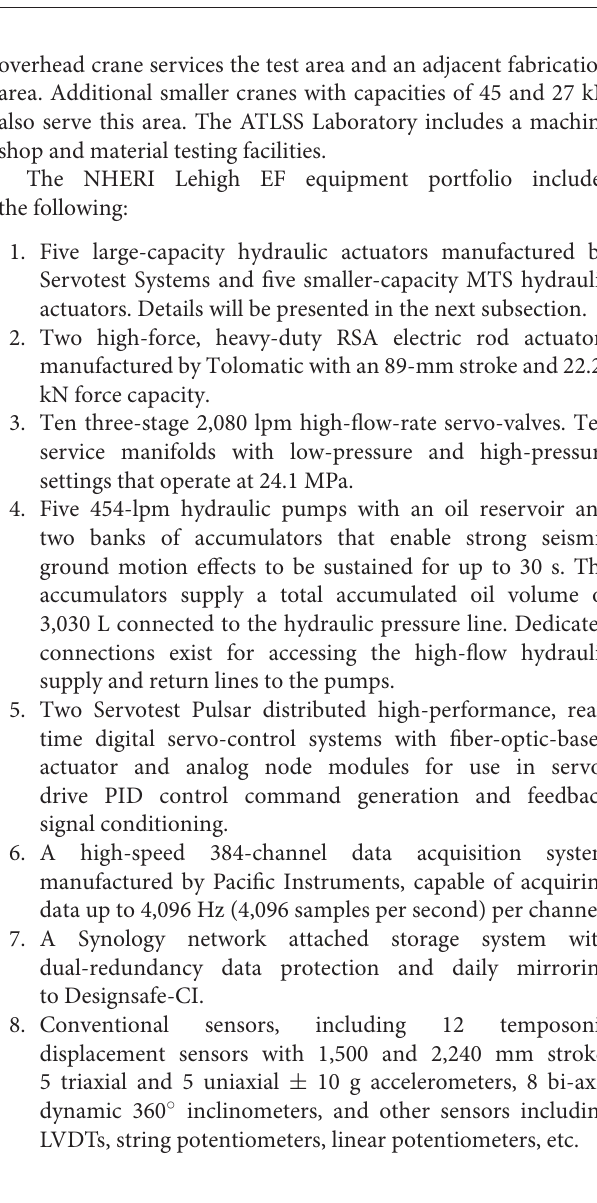
FIGURE 1 | NHERI Lehigh experimental facility